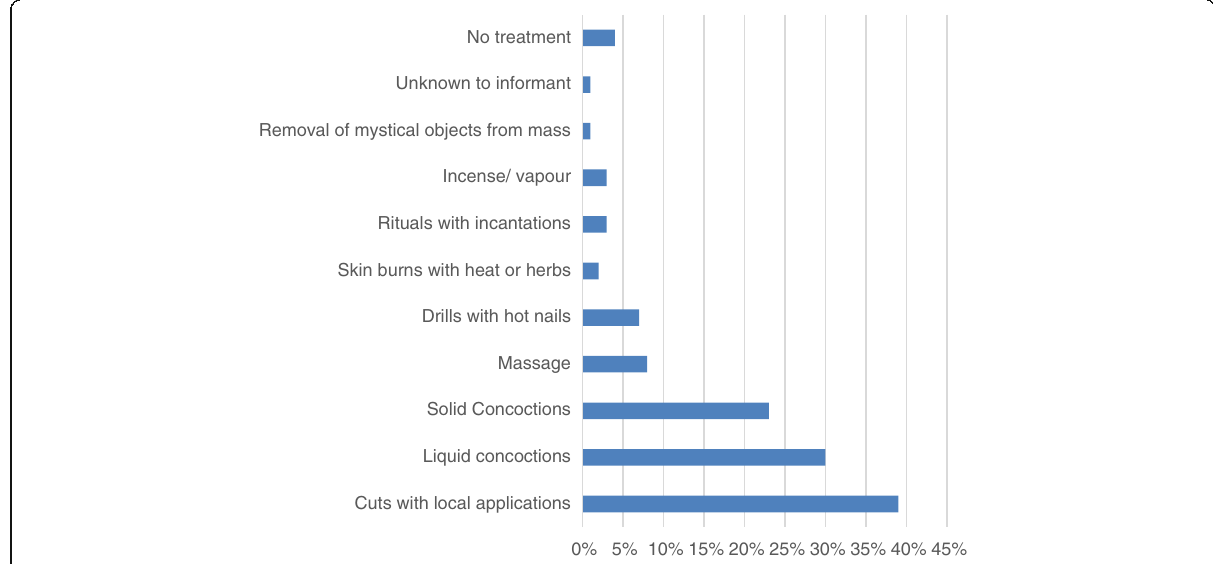
Fig. 1 Treatment methods used by traditional healers to treat Burkitt